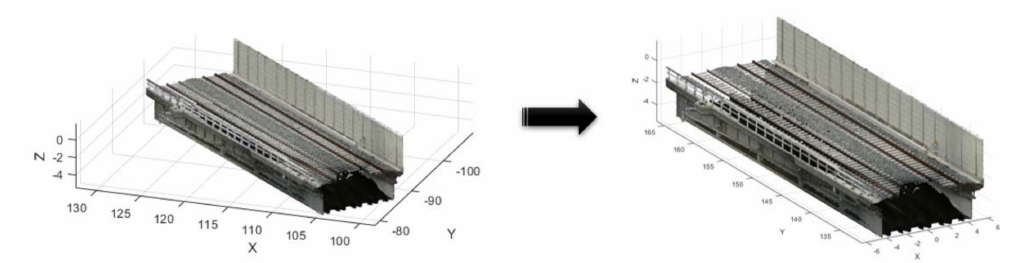
Figure 24. Measurement coordinate system ( left ) and bridge coordinate system ( right ) for the Osong test track fifth bridge.